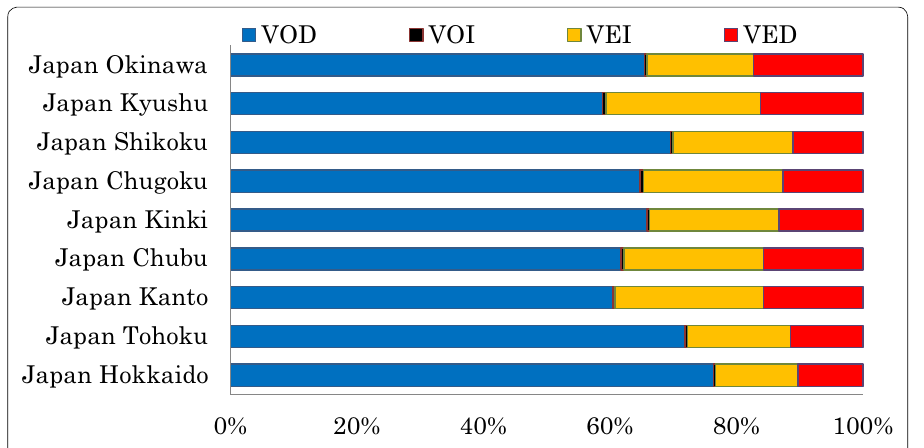
Fig. 6 Domestic region’s GVC participation by route (Japan 2005). VOD: regional value-added outflow through the pure domestic segment of GVCs. VOI: regional value-added outflow through the pure interna- tional segment of GVCs. VEI: regional value-added exports through the pure domestic segment of GVCs. VED: regional value-added exports through the pure international segment of